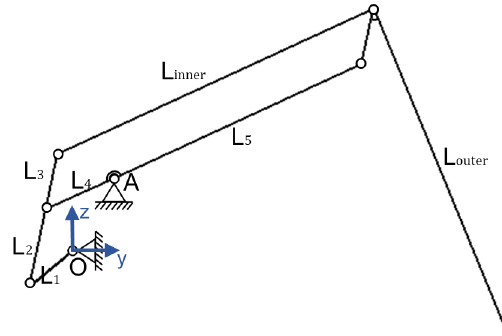
Figure 1. Schematic of the half-wing model.